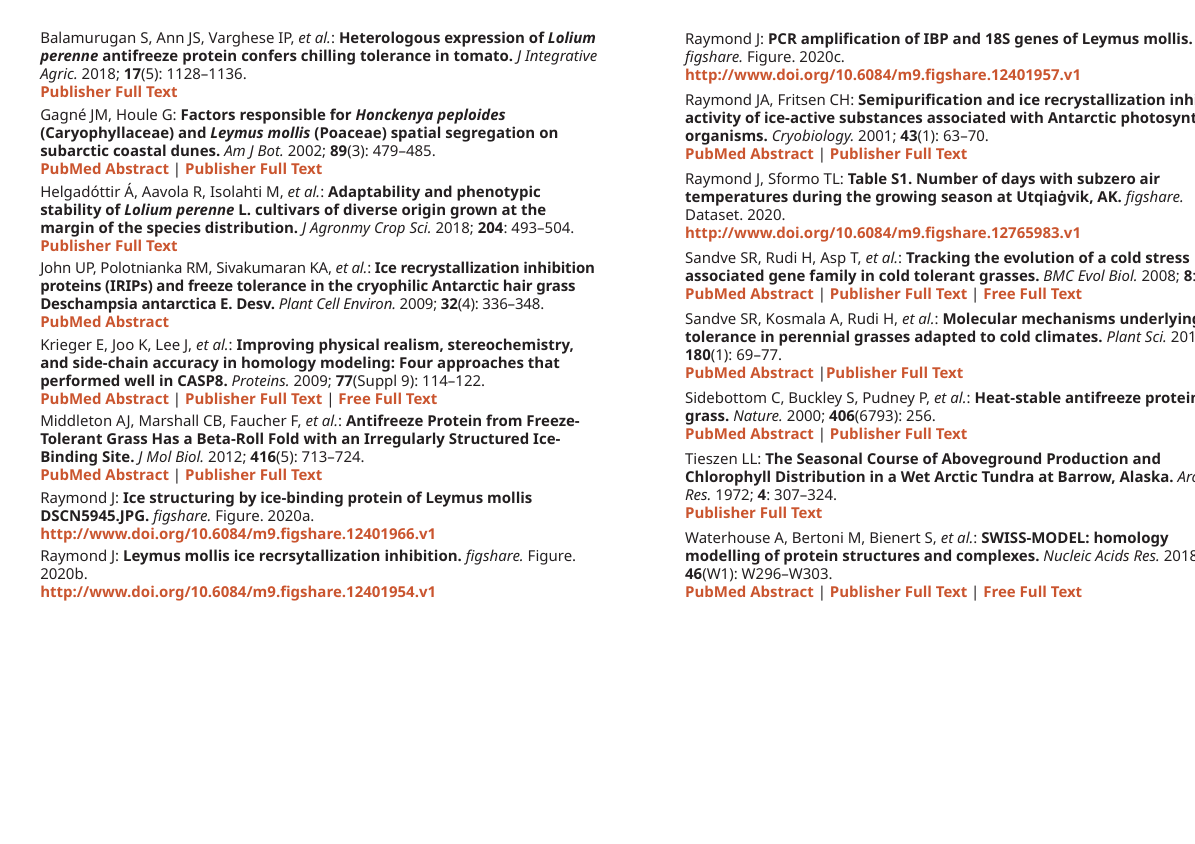
Extended data Figshare : Table S1. Number of days with subzero air temperatures during the growing season at Utqia ġ vik, AK.